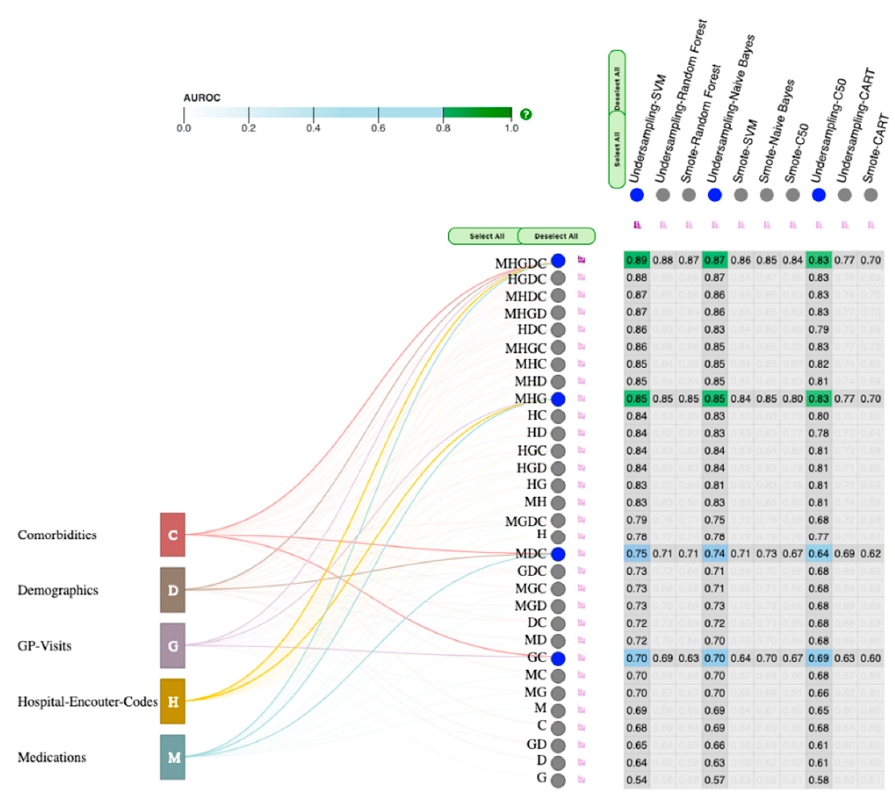
Figure 5. How the system gets updated when users select a circle representing subsets. Users can observe the performance of different analysis techniques by clicking on circles representing the combinations. This interaction highlights all the cells in the heatmap representing the selected column. When a circle gets selected, its color changes to dark blue. As shown in Figure 6, when several subset nodes (or group nodes) and circles representing analysis techniques are selected simultaneously, the color of all the cells that both their rows and columns are selected changes based on the gradient scales mentioned above (i.e., shades of green or blue based on the value of the cell’s AUROC). Users can also hover the mouse over the cells in the heatmap to highlight the labels and circles representing the hovered cell. Additionally, this interaction changes the cell’s color based on its corresponding AUROC value. The system enables users to sort the cells by rows and columns based on their corresponding AUROC values by clicking on the pink sort icons. For instance, cells in the heatmap are sorted by the “MHGDC” subset and “undersampling-SVM” technique in Figure 6.